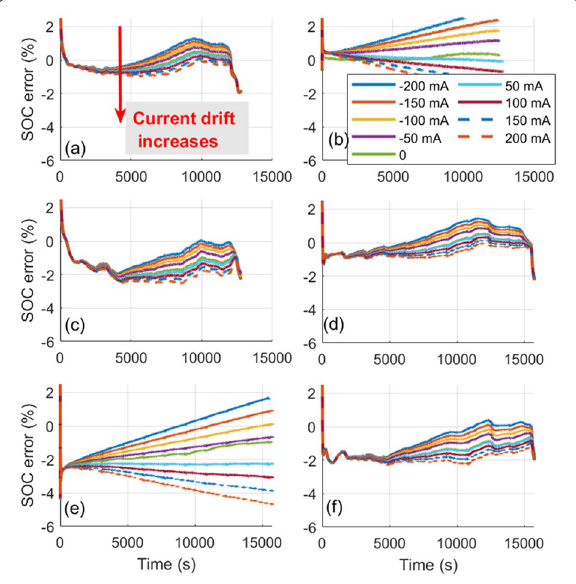
Figure 16 SOC estimation errors under different current drifts: a R(RQ) for DST profile, b R(RWQ) for DST profile, c R(RQ)(RQ)W for DST profile, d R(RQ) for UDDS profile, e R(RWQ) for UDDS profile, f R(RQ) (RQ)W for UDDS